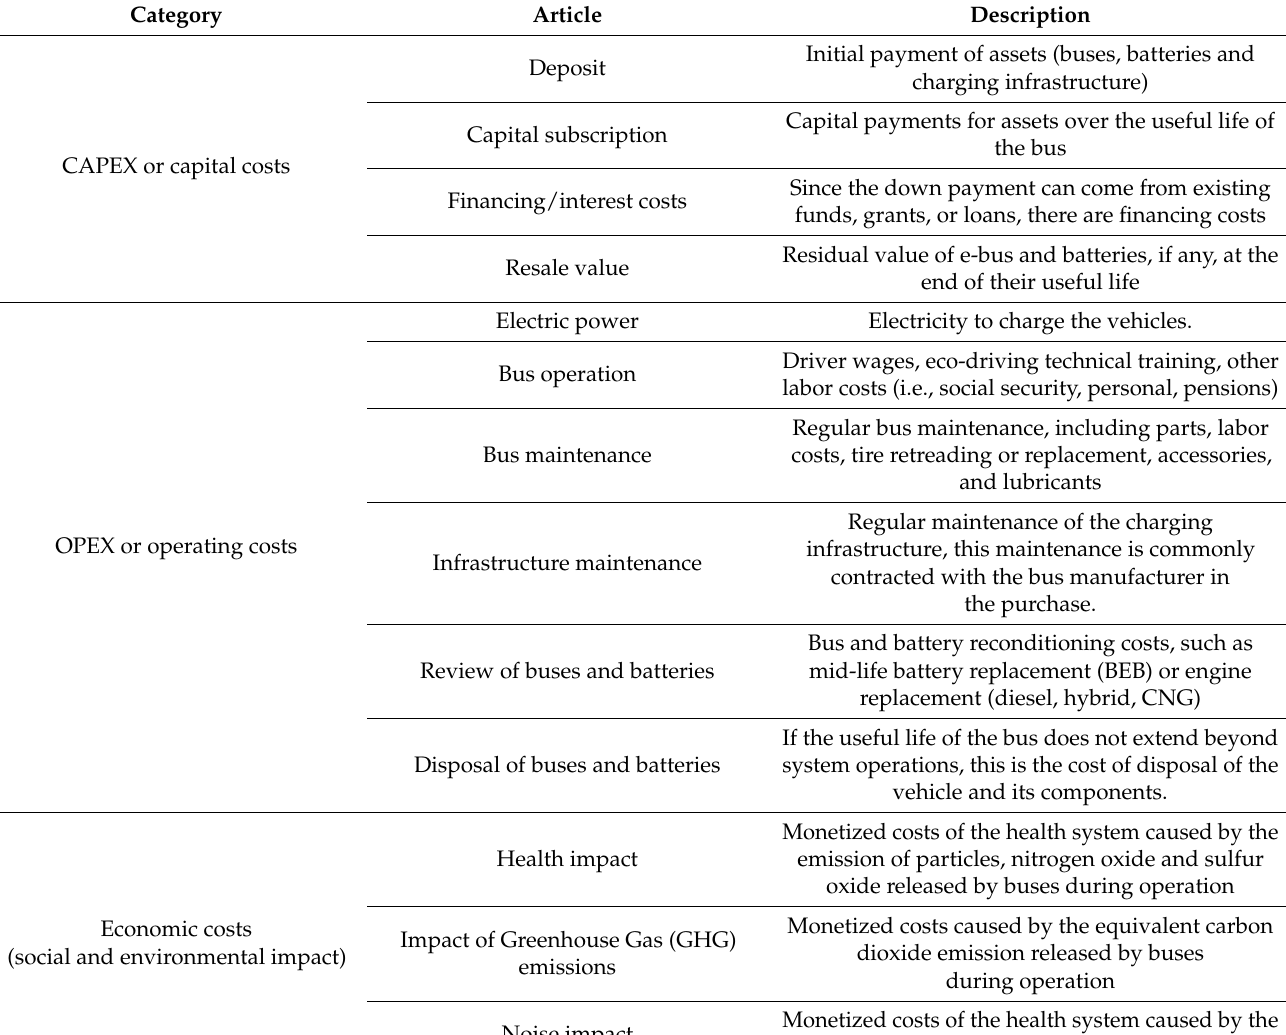
Table 8. Total cost of ownership categories (based on IDOM and ITDP